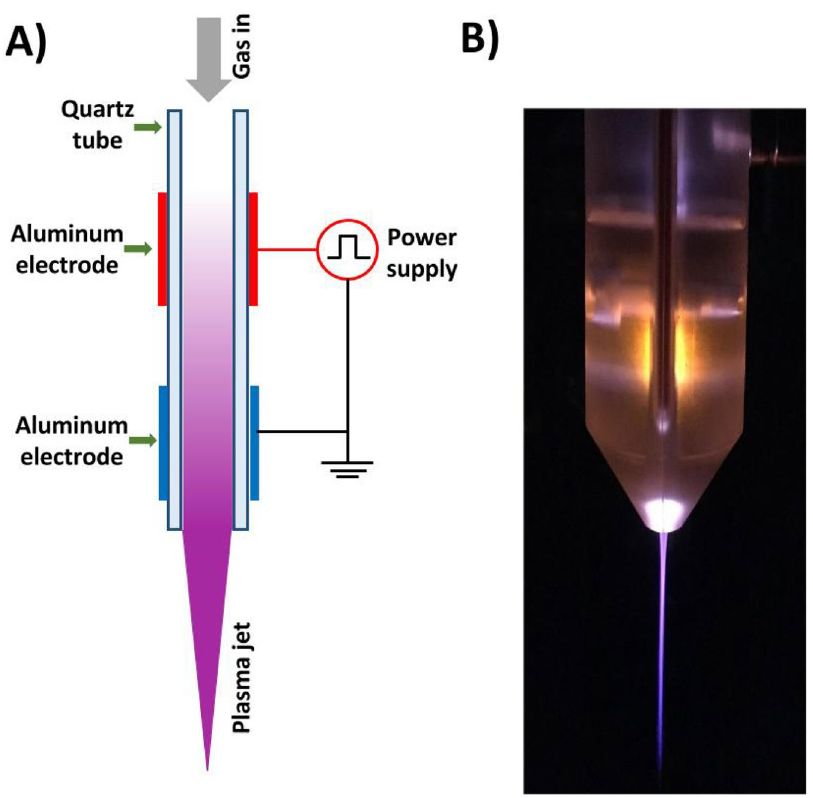
Figure 12. Low temperature plasma jet at atmospheric pressure. ( A ) Schematic diagram of plasma device. ( B ) Picture of plasma jet.